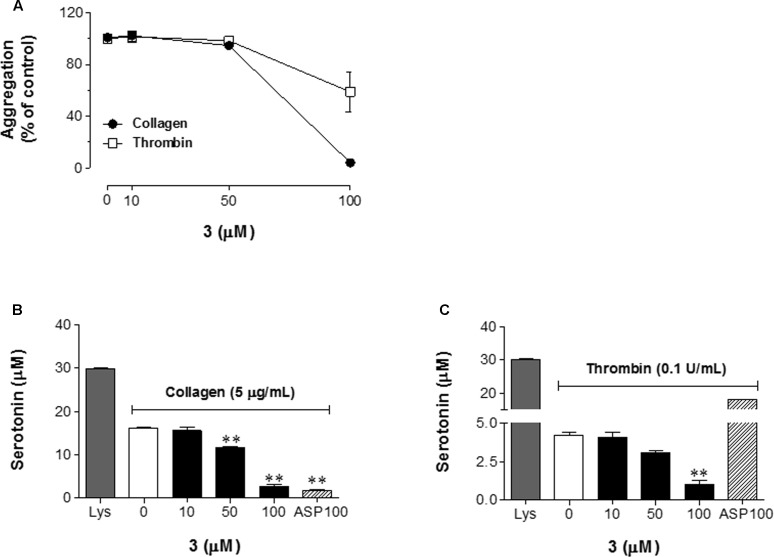
3 increases platelet aggregation and serotonin secretion. (A) Platelet aggregation was induced by the addition of collagen (5 μg/mL), or thrombin (0.1 U/mL). (B,C) Washed rabbit platelet suspensions were incubated with a serotonin re-uptake inhibitor, imipramine (5 μM) following 3 (10–100 μM) treatment for 5 min prior to the addition of collagen (5 μg/mL, B), or thrombin (0.1 U/mL, C). Serotonin secretion in the supernatant was determined by fluorometric assay. Lys indicates total serotonin content in the supernatant of cell lysate. Data are expressed as the means ± SEM (n = 3). ∗∗p < 0.01 vs. control (collagen or thrombin treatment, but no 3).